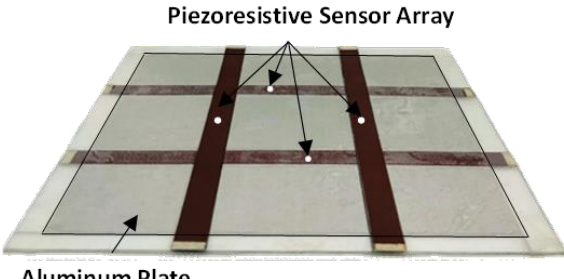
Figure 4. Picture of the grid constituted by the two orthogonal couples of piezoresistive sensors on an aluminum an aluminum plate.